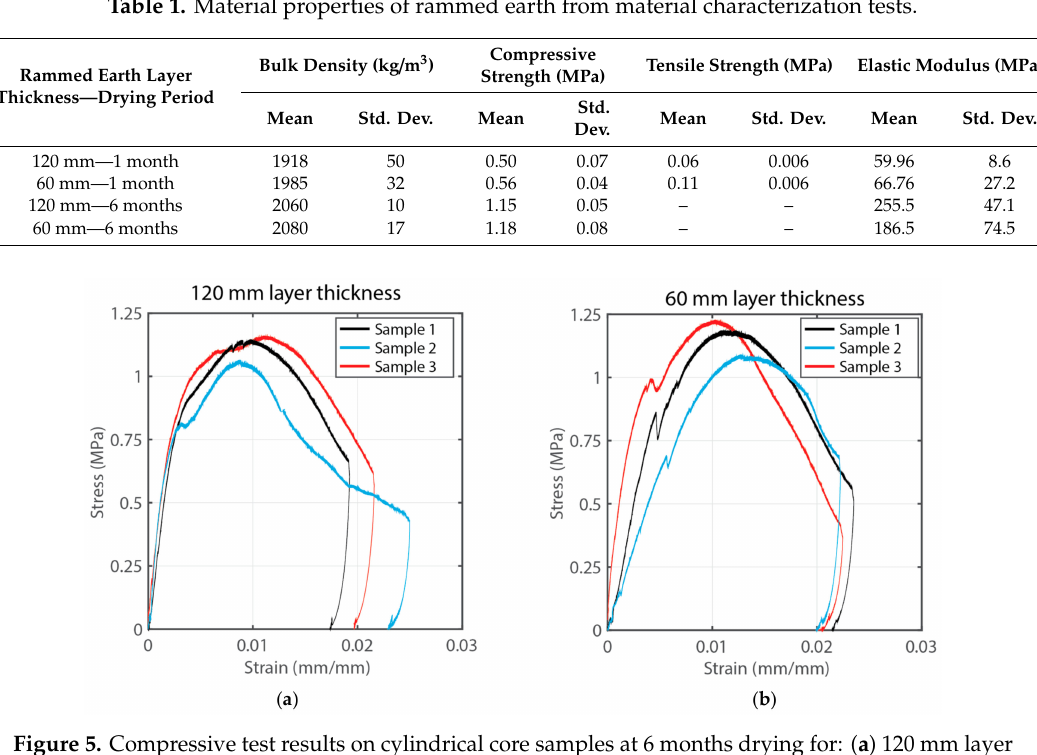
Figure 5. Compressive test results on cylindrical core samples at 6 months drying for: ( a ) 120 mm layer RE; ( b ) 60 mm layer RE.